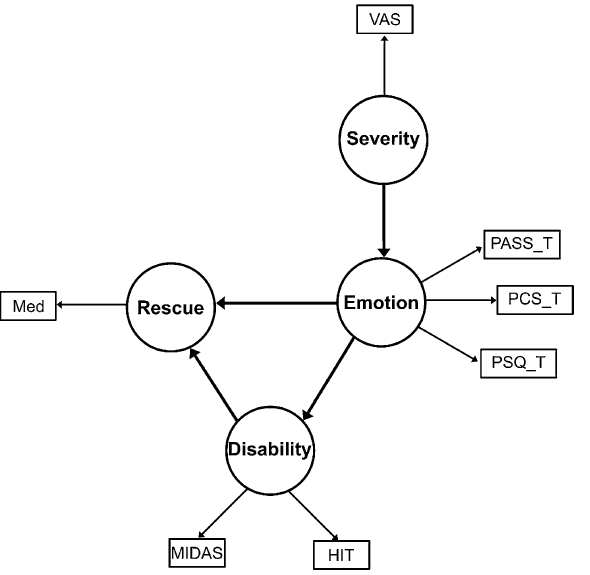
Figure 1. Path illustration of the hypothesized model. Note PASS_T, PASS-Total; PCS_T, PCS-Total, PSQ_T, PSQ-Total; Severity, headache severity; VAS, visual analog scale; Rescue, abortive use; Med, frequency of abortive medication